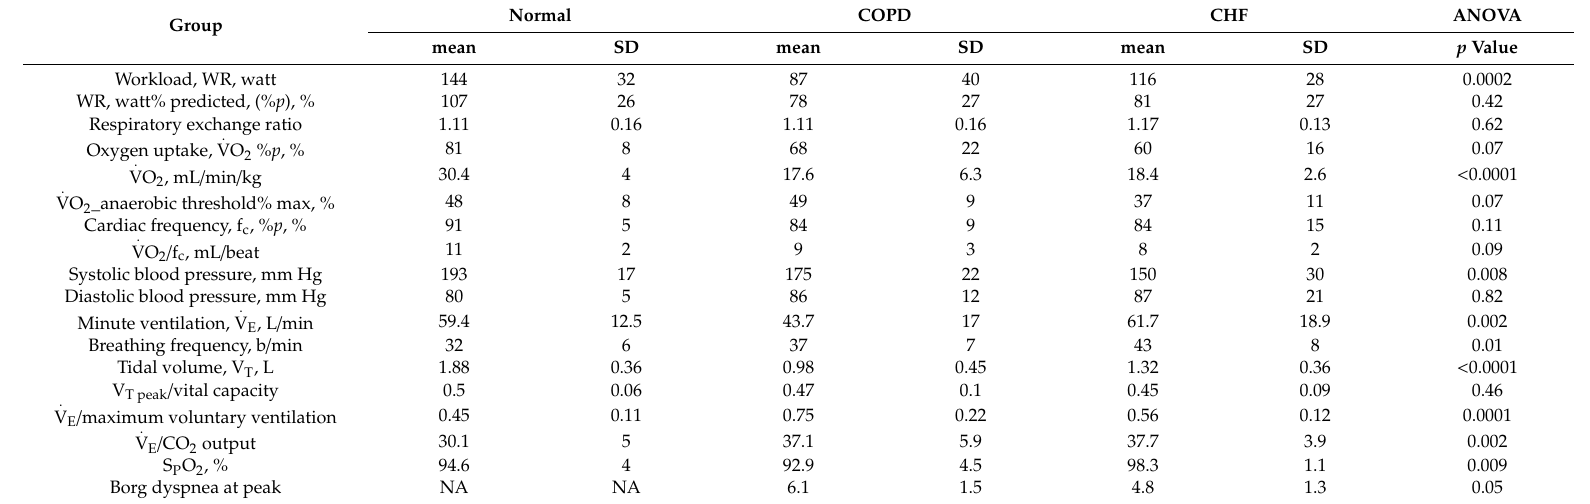
Table 2. Cardiopulmonary exercise test at peak